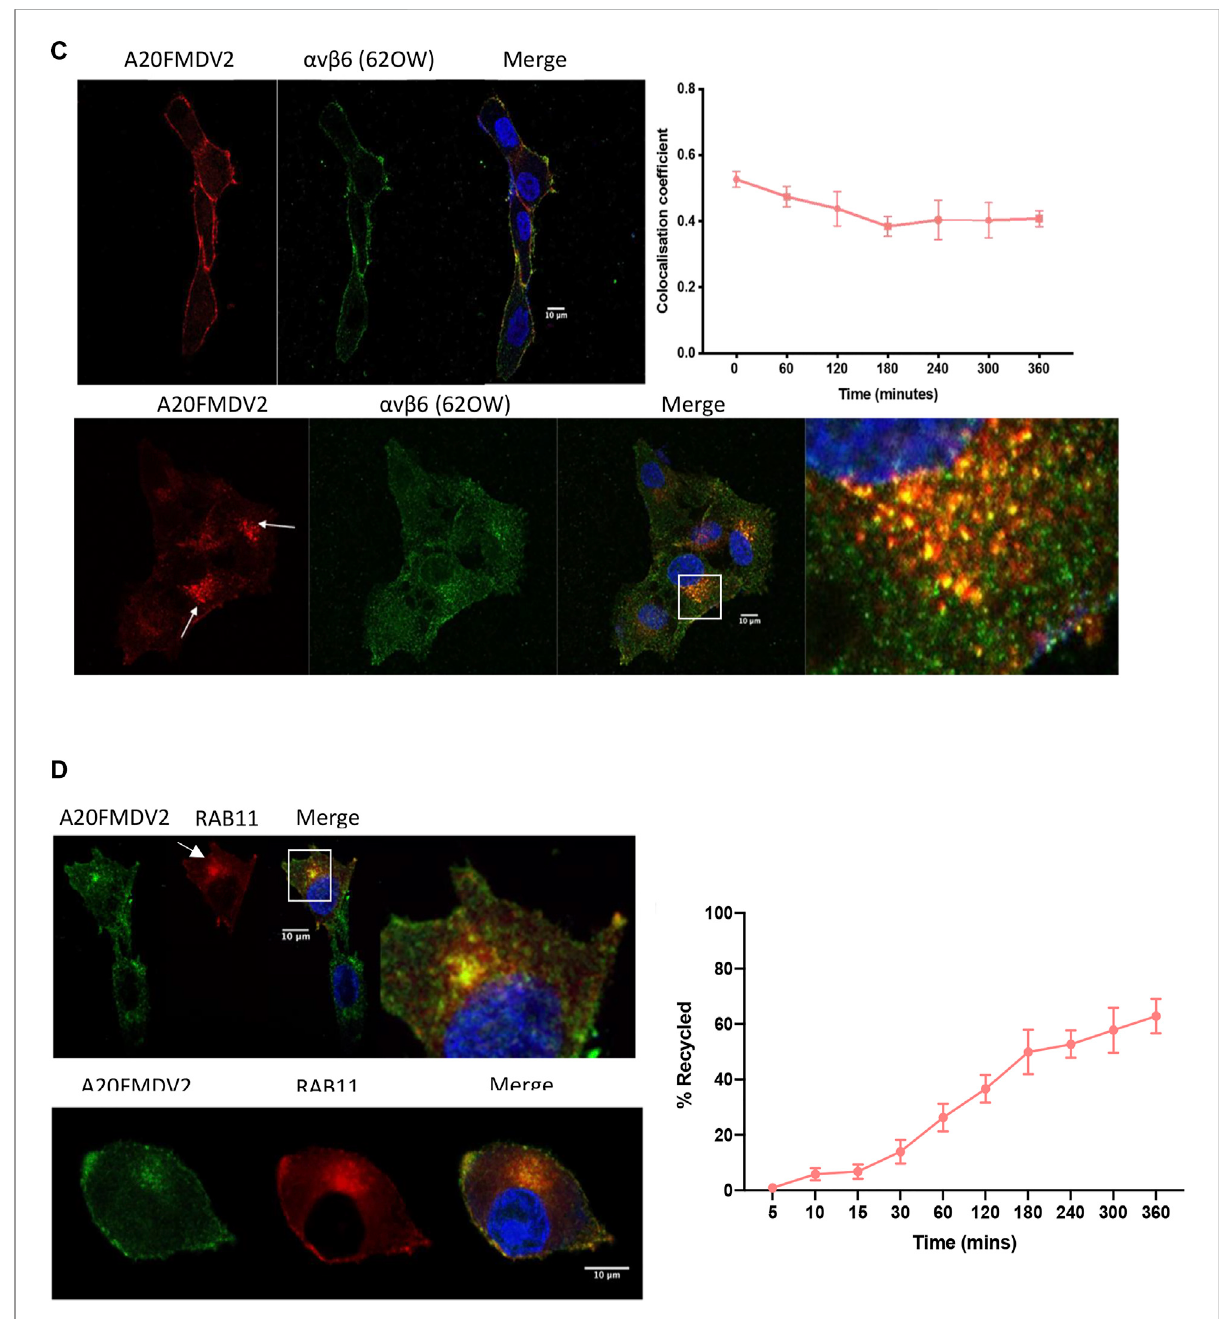
FIGURE 5 Traf fi cking dynamics of A20FMDV2- α v β 6 post-endocytosis. (A) Representative images of A375 β 6 cells following Cy5-(GS)5-bioA20FMDV2 (red) internalisation and counterstained with EEA1 (green). At the 0-min time point, A20FMDV2 is mostly at the cell surface, and the EEA1 is spread throughout the cell. From 10 to 30 min both EEA1 and A20FMDV2 appear in concentrated clusters close to the nucleus, but this staining is not present from 120 min onwards. (B) Validation of pH sensitivity of pHrodo conjugated peptide [(i – iii) performed at time point 0] (i) pHrodo fl uorescenceatneutralpH,measuredusing fl owcytometry(ii)ValidationofpHrodo-A20FMDV2speci fi city.A375 β 6andA375Pcellswereexposedto A20FMDV2-pHrodo, and the biotin tag used to detect the binding of the peptide to the cells via fl ow cytometry, revealing two distinct populations between A375 β 6 (red) and A375P (orange). Unstained cells are represented in blue. (iii) Validation of pHrodo pH sensitivity: A20FMDV2-pHrodo was incubated in buffers of varying pH and the amount of luminescence (RLU) increases as the pH decreases ( n = 3). (iv) Flow cytometry based -internalisation assay of bio-A20FMDV2-pHrodo in C76 cells showed that fl uorescence consistently increased between 0 and 4 h, with a plateau between 4 and 6 h. Data represents mean values ± SD ( n = 3). (C) A375 β 6 cells were stained with Cy5-(GS)5-bioA20FMDV2 (red) and a non-ligand mimetic α v β 6 speci fi c antibody, 620W (green) in order to determine their association post-endocytosis. (Top Left) Representative image taken before internalisation of Cy5-(GS)5-bioA20FMDV2, demonstrating that A20FMDV2 and 620W are localised together at the cell membrane.